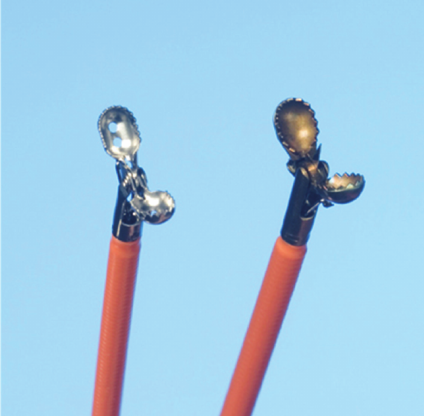
Figure 1: RJ4 (left) and standard large diameter forceps (right). Both are straight shaft forceps with a cup